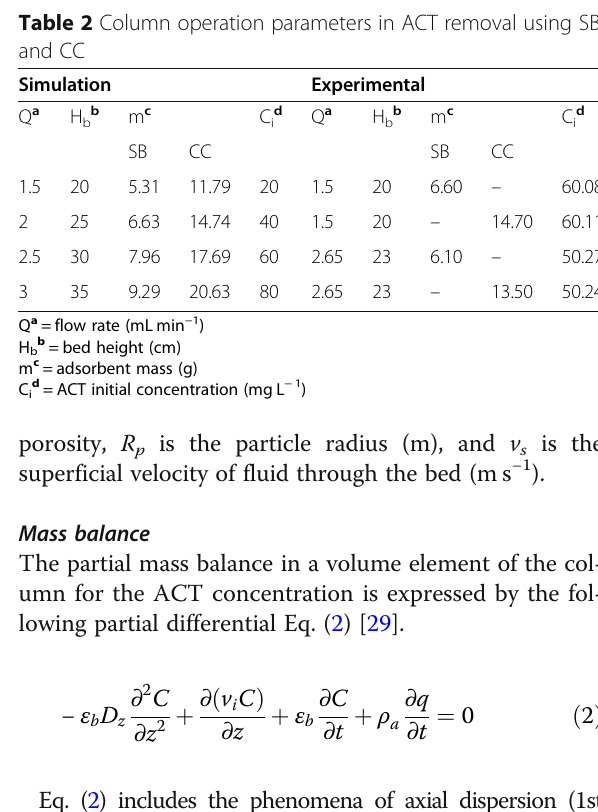
Where, q is the instantaneous equilibrium concentration e (mg g − 1 ) and K is the global mass transfer coefficient i (s − 1 ). When the external fluid film resistance, and pore diffusional resistance are considered, K can be estimated i by Eq. (5) [31].